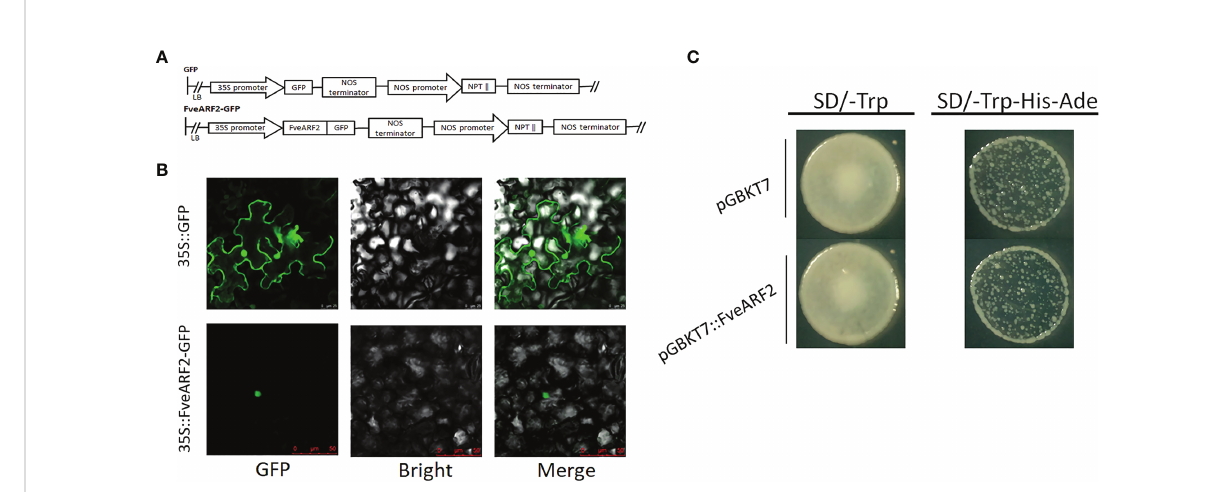
FIGURE 3 Subcellular localization and transcriptional activity of FveARF2. (A) Structural diagram of the 35S::GFP vector and the 35S::FveARF2-GFP construct. (B) Subcellular localization of the FveARF2 protein in Nicotiana benthamiana leaves. 35S::GFP (top) 35S::FveARF2-GFP were expressed in tobacco leaves (bottom), and visualized in the nucleus. Bar = 30 m m. (C) Yeast Y1H Gold cells transformed with pGBKT 7 ::FveARF2 and analysis of these cells on SD/-Trp and SD/-Trp-His-Ade plates to evaluate whether FveARF2 has transcriptional activation